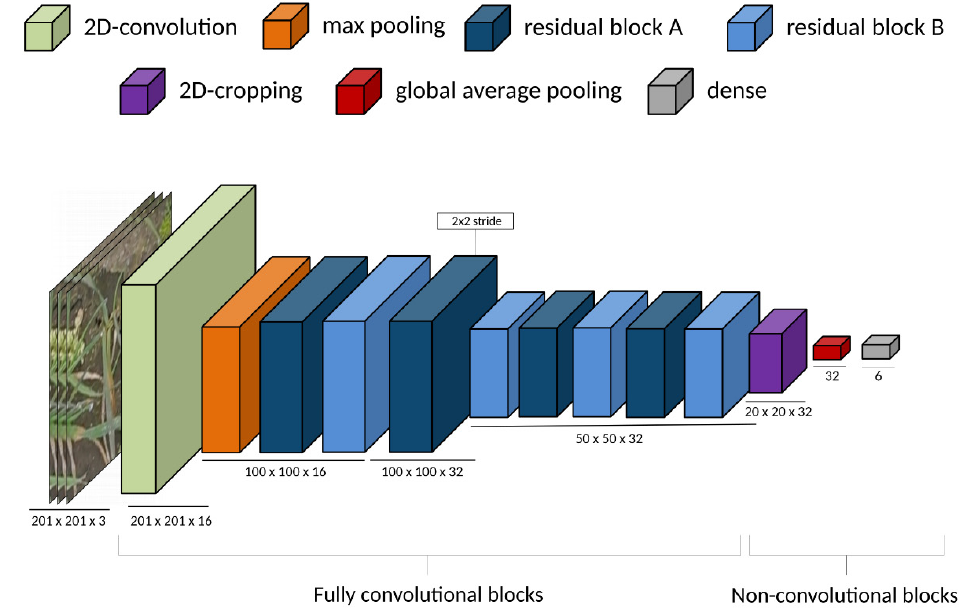
Figure 1. Proposed residual neural network architecture for classification of 201 × 201 px image patches. All convolution layers are followed by batch normalization layers and ReLU activations. Max pooling layers implement 2 × 2 maximum pooling with stride two. The final dense layer contains class scores for the six classes.